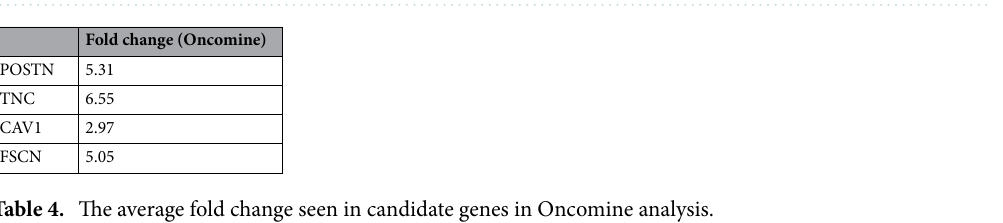
Figure 1. ( A ) Correlation among these database gene list revealed 181 common genes, metastatic in origin. ( B ) The cluster analysis of predicted 54 genes using STRING. The identified clusters are coloured in green ( A ), red ( B ) and blue ( C ). The solid and the dotted lines indicate connection within the same and different cluster respectively. Different colour indicates different type of interactions. b: Four genes of relevance in accordance to the interaction with TGF β and EGFR clustered together on basis of literature review. ( C ) The analysis of PPIs using STRING to identify interaction of candidate genes POSTN, TNC, CAV1 and FSCN1 in OSCC. ( D ) Heat map representing the average fold change compared to the normal sample from Oncomine (mRNA, OSCC) and Cancer RNA-Seq Nexus (RNA-Seq data, HNSCC).